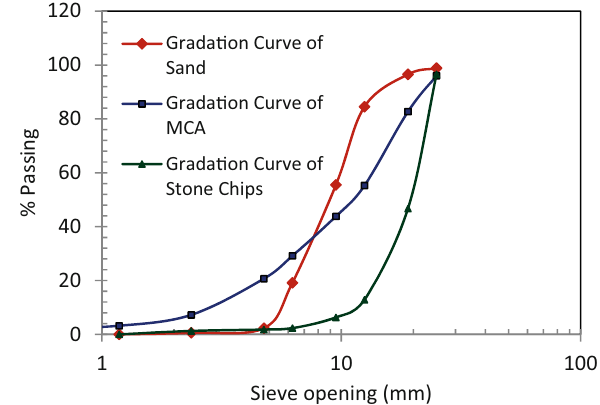
Fig. 2 Gradation curves of sand, masonry chip aggregate (MCA) and stone